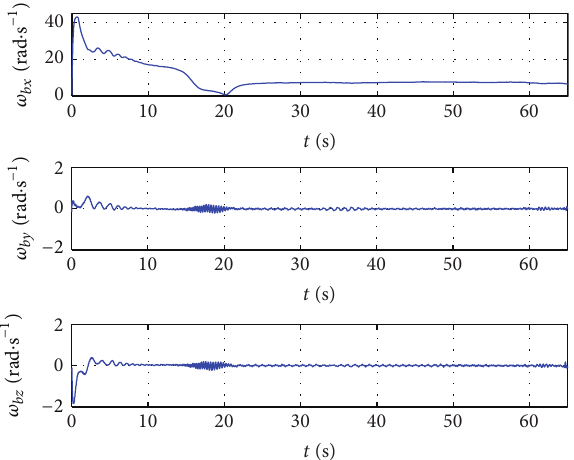
Figure 2: Measurement data of the MEMS triaxial